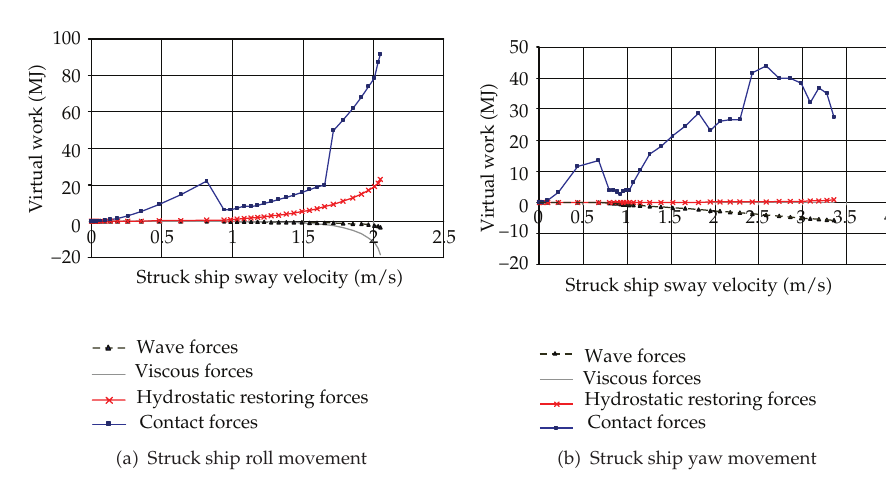
Figure 15: Virtual work of involved hydrodynamic forces. Table 3: Ships main